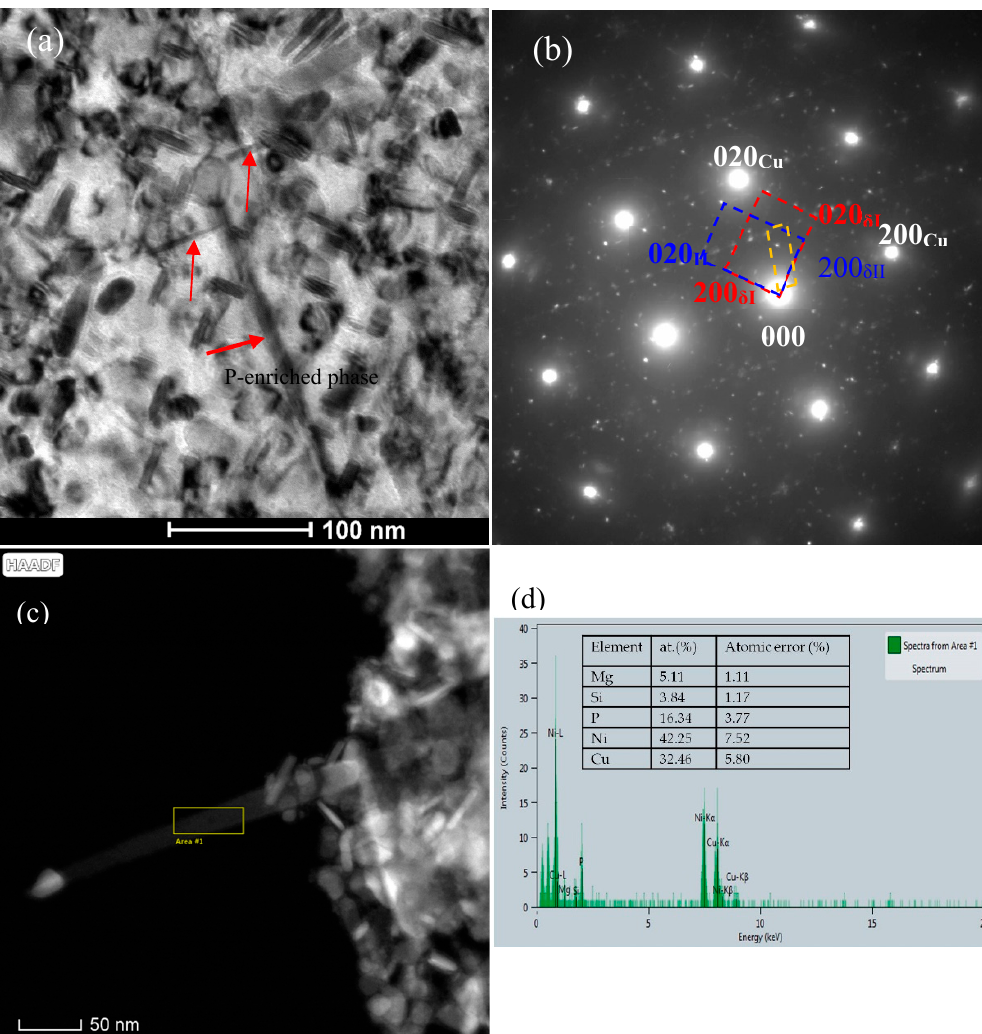
Figure 8. TEM and STEM images of C0 alloy aged at 500 °C for 16 h ( a ) [001] Cu BF image, ( b ) corresponding [001] Cu SAED pattern of ( a ), two sets of pattern (marked by red and blue dash line) belong to the two δ -Ni 2 Si variants, one (marked by yellow dash-line) belongs to the P-enriched phase. ( c ) HAADF image of needle-like P-enriched phase and δ -Ni 2 Si variants, ( d ) EDS analysis result of P-enriched phase (labeled by “Area #1” in ( c ). Red arrow in (a) refer to the P-rich phase.